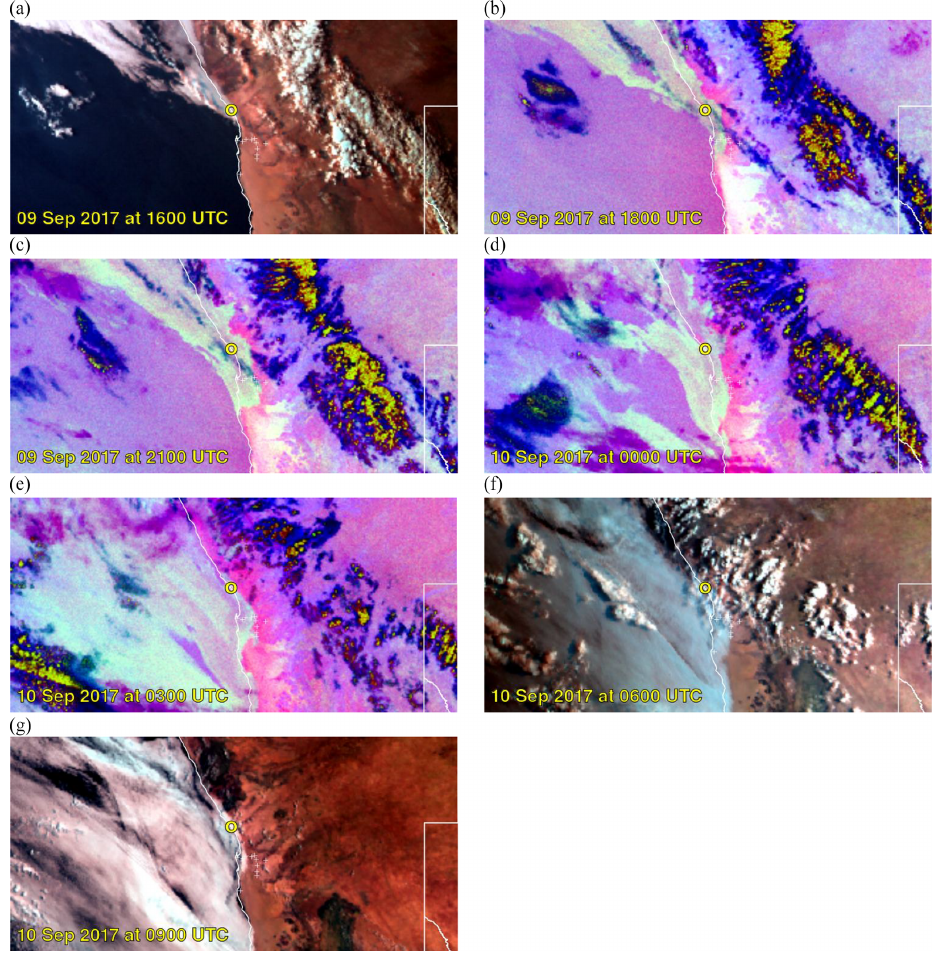
Figure 5. SEVIRI images of night microphysical RGB product (b–e) and day visible channels (a, f, g) for the fog event on 10 Septem- ber 2017. The yellow open circle is the study site. The site is UTC + 2. The extent matches the WRF model 3km domain, which extends 1386km (east–west) by 720km (north–south).